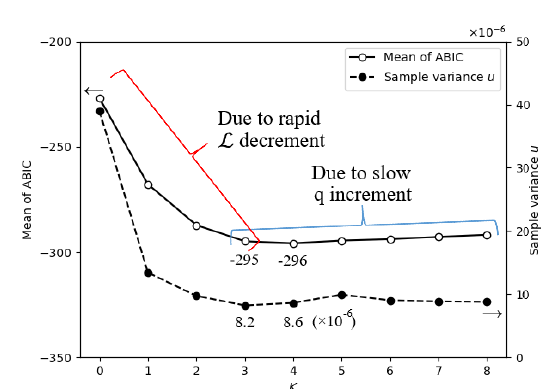
Fig. 13. Relationship between changes in the mean of ABIC and sample variance